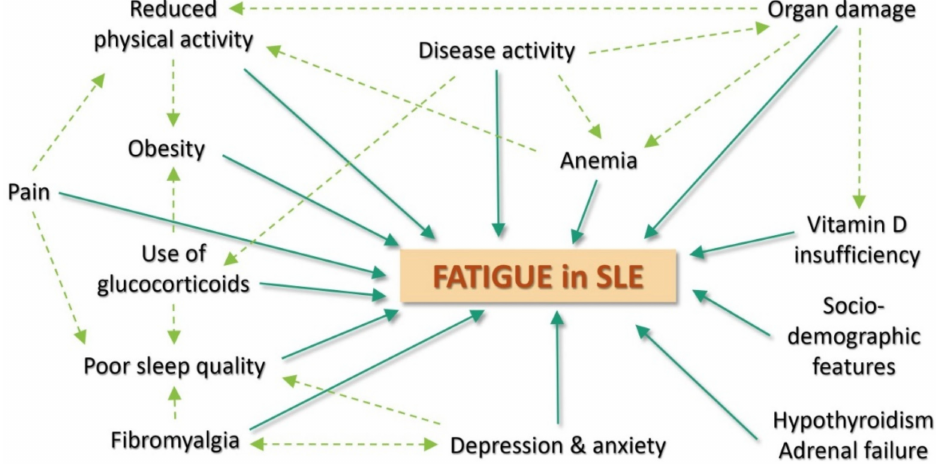
Figure 1. Main determinants of fatigue in Systemic Lupus